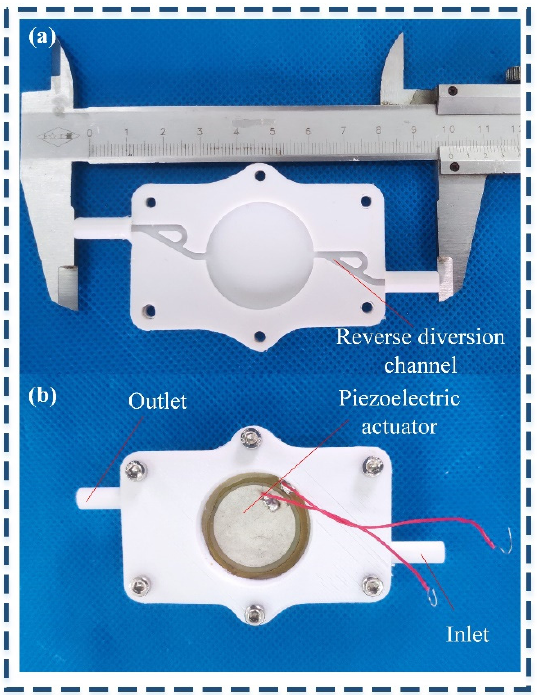
Figure 6. ( a ) Parts drawing of the valveless piezoelectric pump with reverse diversion channel (Tesla valve) with fluid guiding body; ( b ) prototype of the valveless piezoelectric pump with reverse diversion channel (Tesla valve).